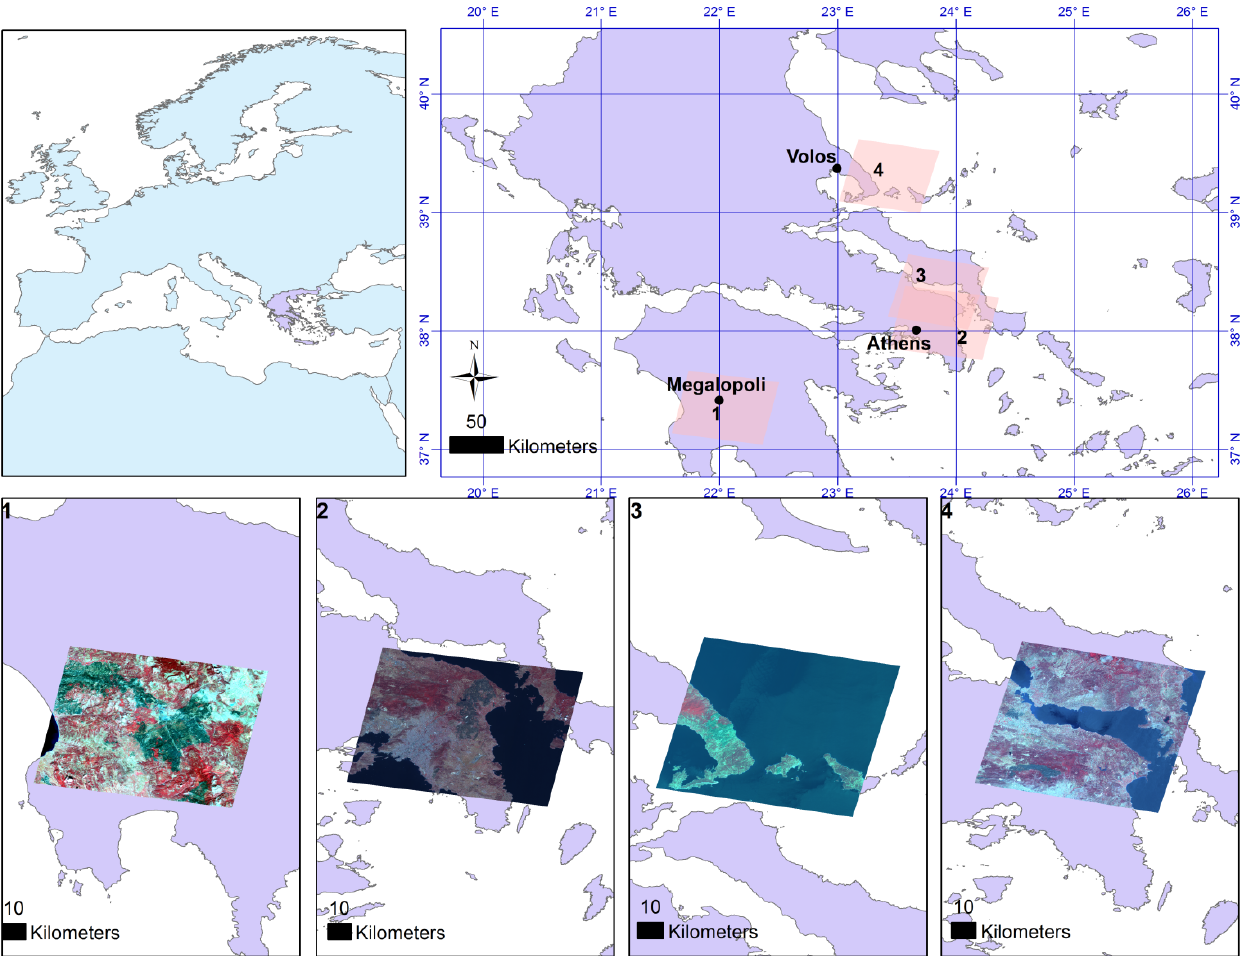
Figure 1. Location of the four study areas, extent of each image (orange boxes) and corresponding available SPOT-4 HRVIR images: ( 1 ) Peloponnese, ( 2 ) East Attica, ( 3 ) Parnitha, and ( 4 )